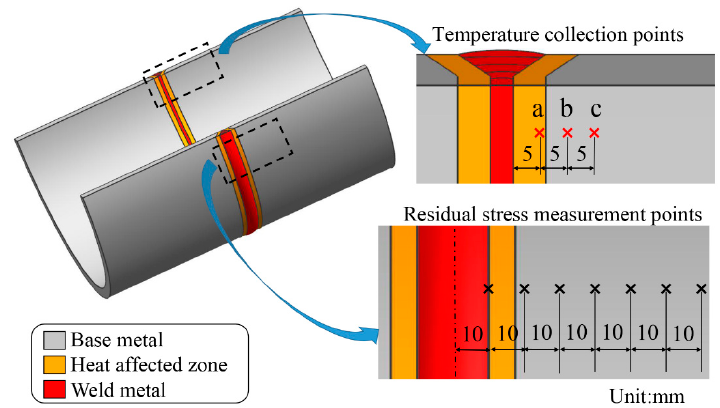
Figure 3. Schematic of temperature and residual stress measurement points.